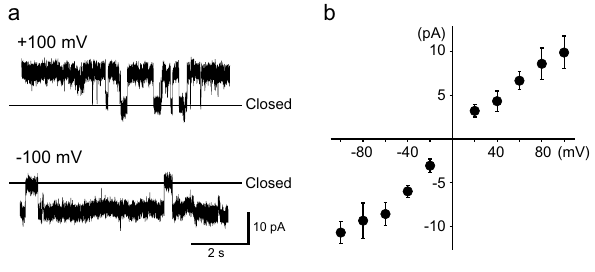
Figure 4. Single-channel currents measured with lipids dissolved in n -hexadecane using a hydrophobically modified probe. (a) Representative current traces of KcsA channels (KcsA(E71A)) measured in the bilayer membrane consisting of POPE–POPG dissolved in n -hexadecane, which is a thinner membrane than that obtained with POPE–POPG dissolved in n -decane, at ± 100 mV. (b) Current–voltage relationship of KcsA(E71A) channels (n = 7). POPE 1-palmitoyl-2-oleoyl-sn-glycero-3-phosphoethanolamine; POPG 1-palmitoyl-2-oleoyl-sn-glycero-3-[phospho-rac-(1-glycerol)]; POPE–POPG lipid solution consisting of 18 mg/ ml POPE and 6 mg/ml